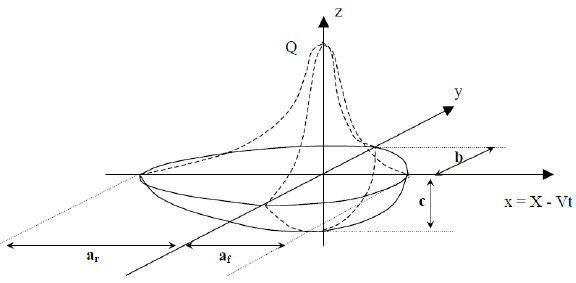
Figure 2. Goldak’s double-ellipsoid